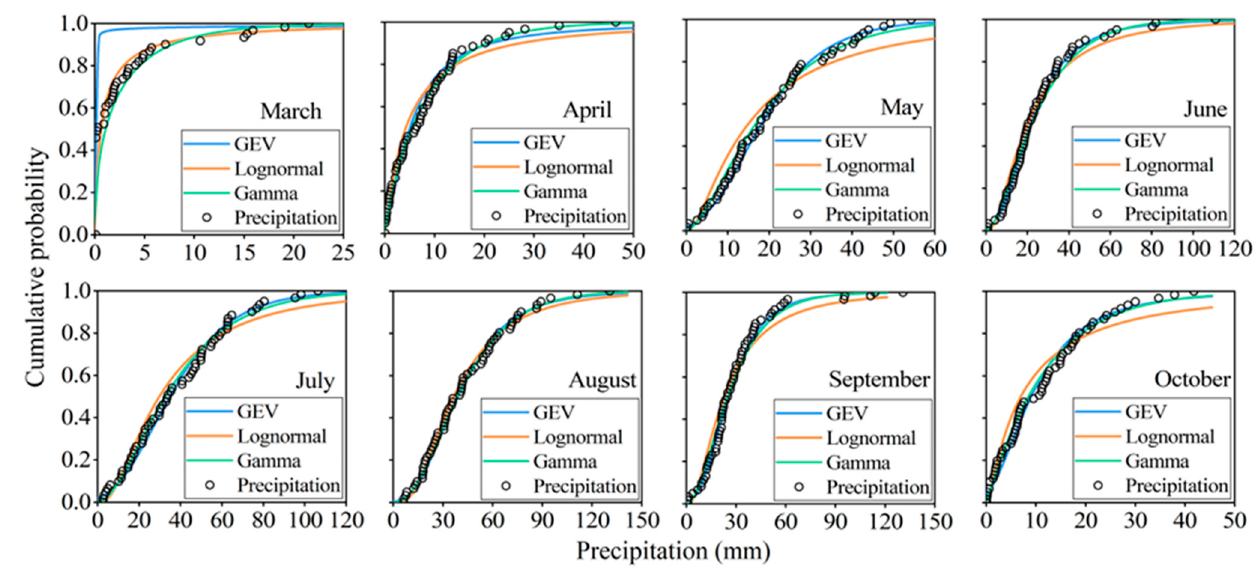
Figure 7. Fitting diagram of marginal distribution for monthly precipitation. (The points represent monthly precipitation monitored by the weather station from 1960 to 2020. The curves represent the fitting results of three marginal distribution functions). Table 3. Parameters of marginal distribution for monthly reference evapotranspiration.